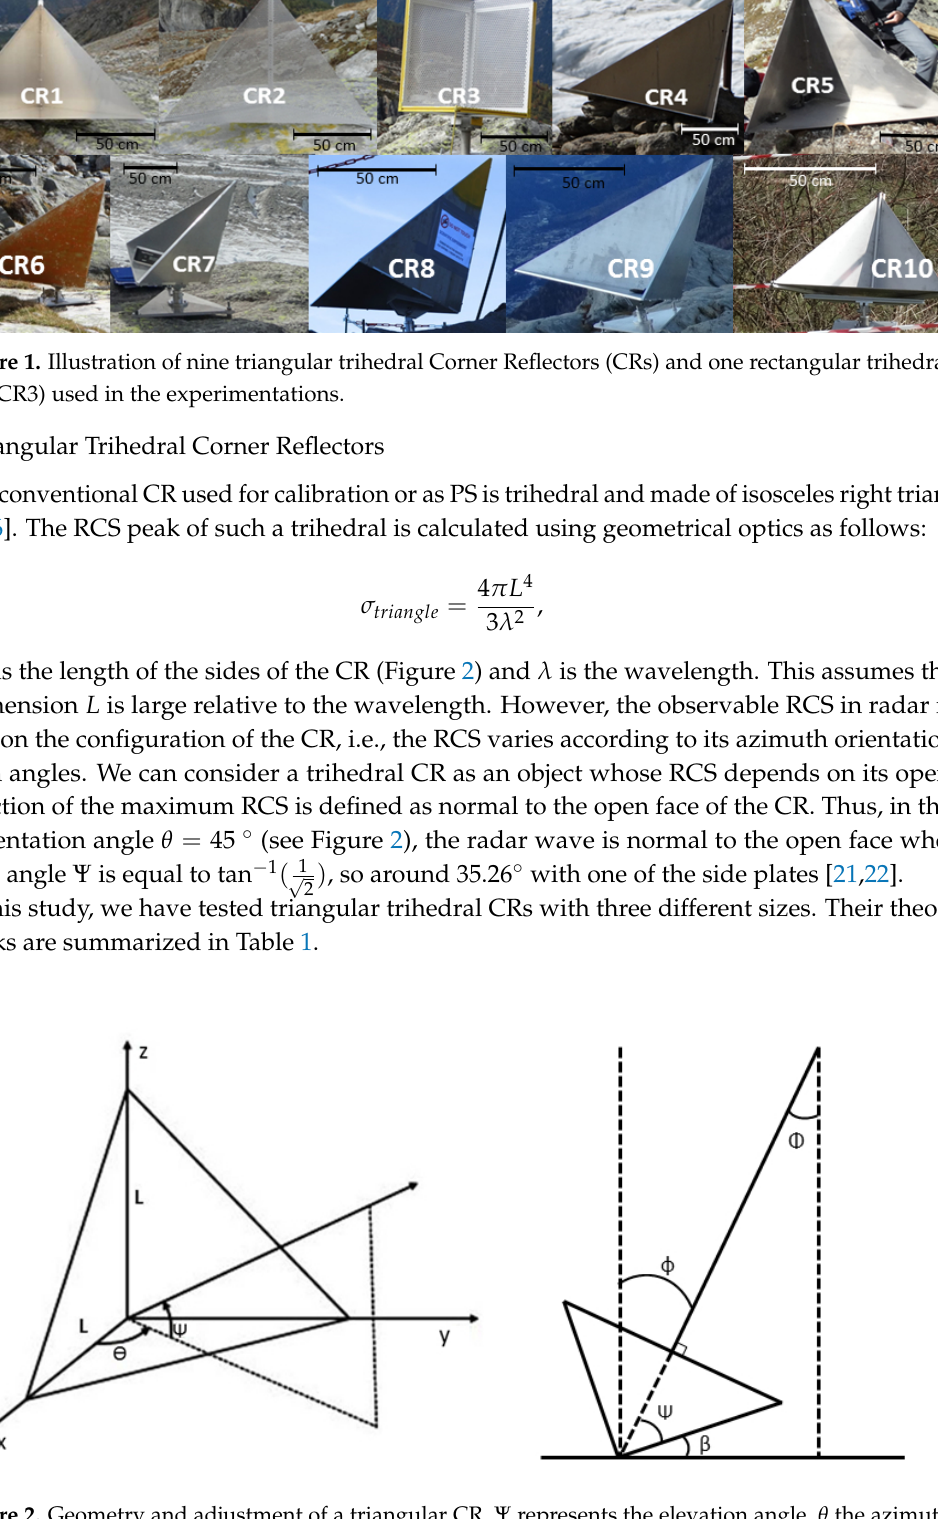
Figure 2. Geometry and adjustment of a triangular CR. Ψ represents the elevation angle, θ the azimuth angle, Φ the off-nadir angle, φ the incidence angle, β the tilt angle and L the smaller side length of isosceles right triangular